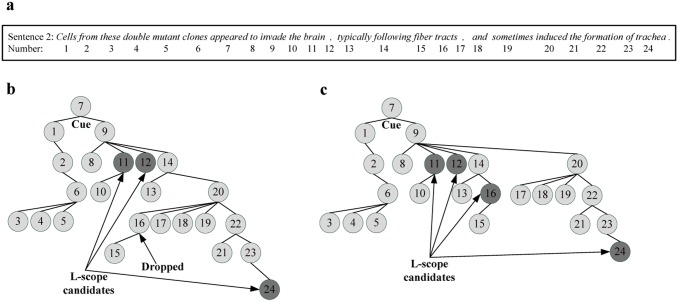
An example of a sentence with the L-scope token dropped due to parsing errors.(a) The sequence number of tokens in sentence 2; (b) DCBS drops the L-scope node 16 due to incorrect dependency tree; (c) DCBS selects the L-scope node 16 accurately based on correct dependency tree.